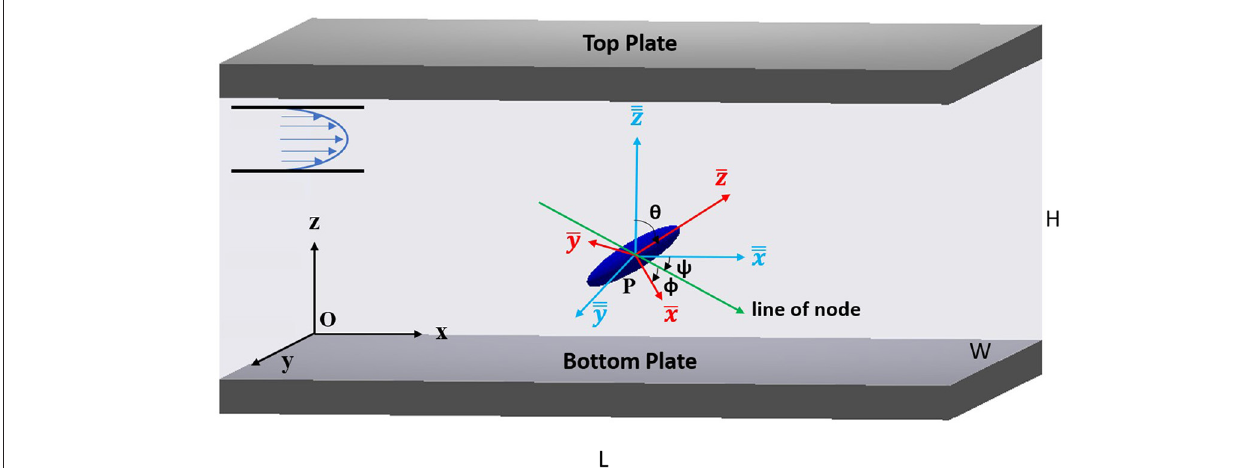
FIGURE 1 | Representation of parallel plate simulation geometry including Euler angles and coordinate systems: inertial frame [ x , y , z ] with origin O on the bottom plate, particle frame [ x , y , z ] and co-moving frame h x , y , z i with origin P at the particle center. Fluid flow direction was along positive x. The insert showed the parabolic flow inside the channel.